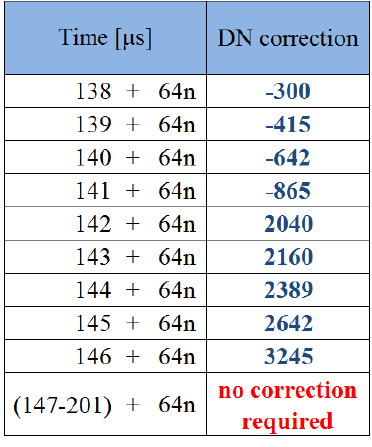
Correction values for DN obtained from imagery acquired at given integration